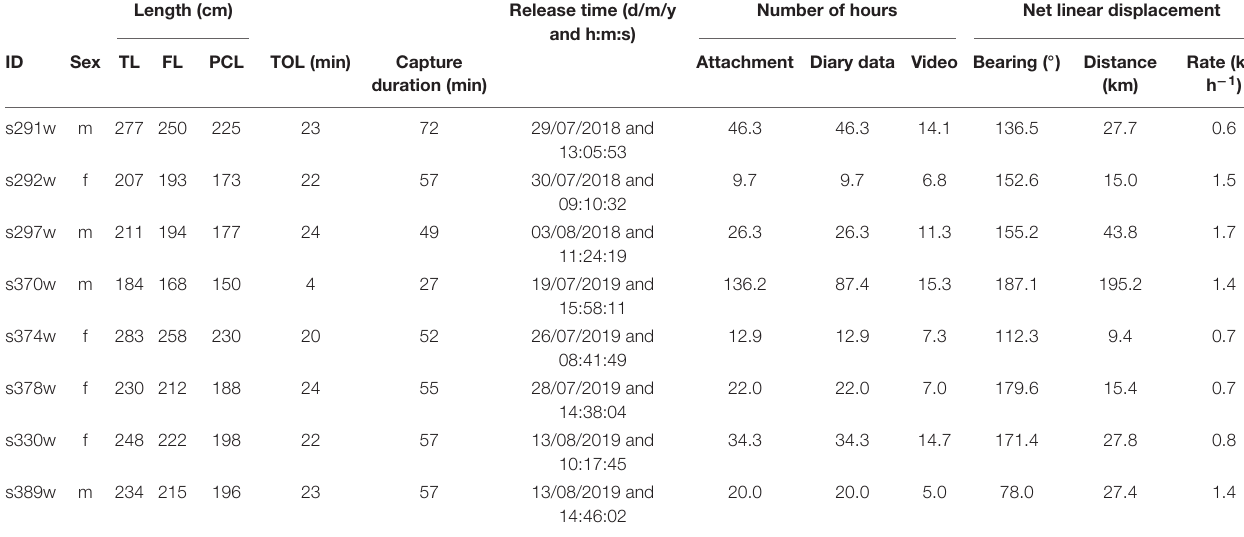
TABLE 1 | Information for CATS cam deployments on white sharks released from SMART drumlines. Length